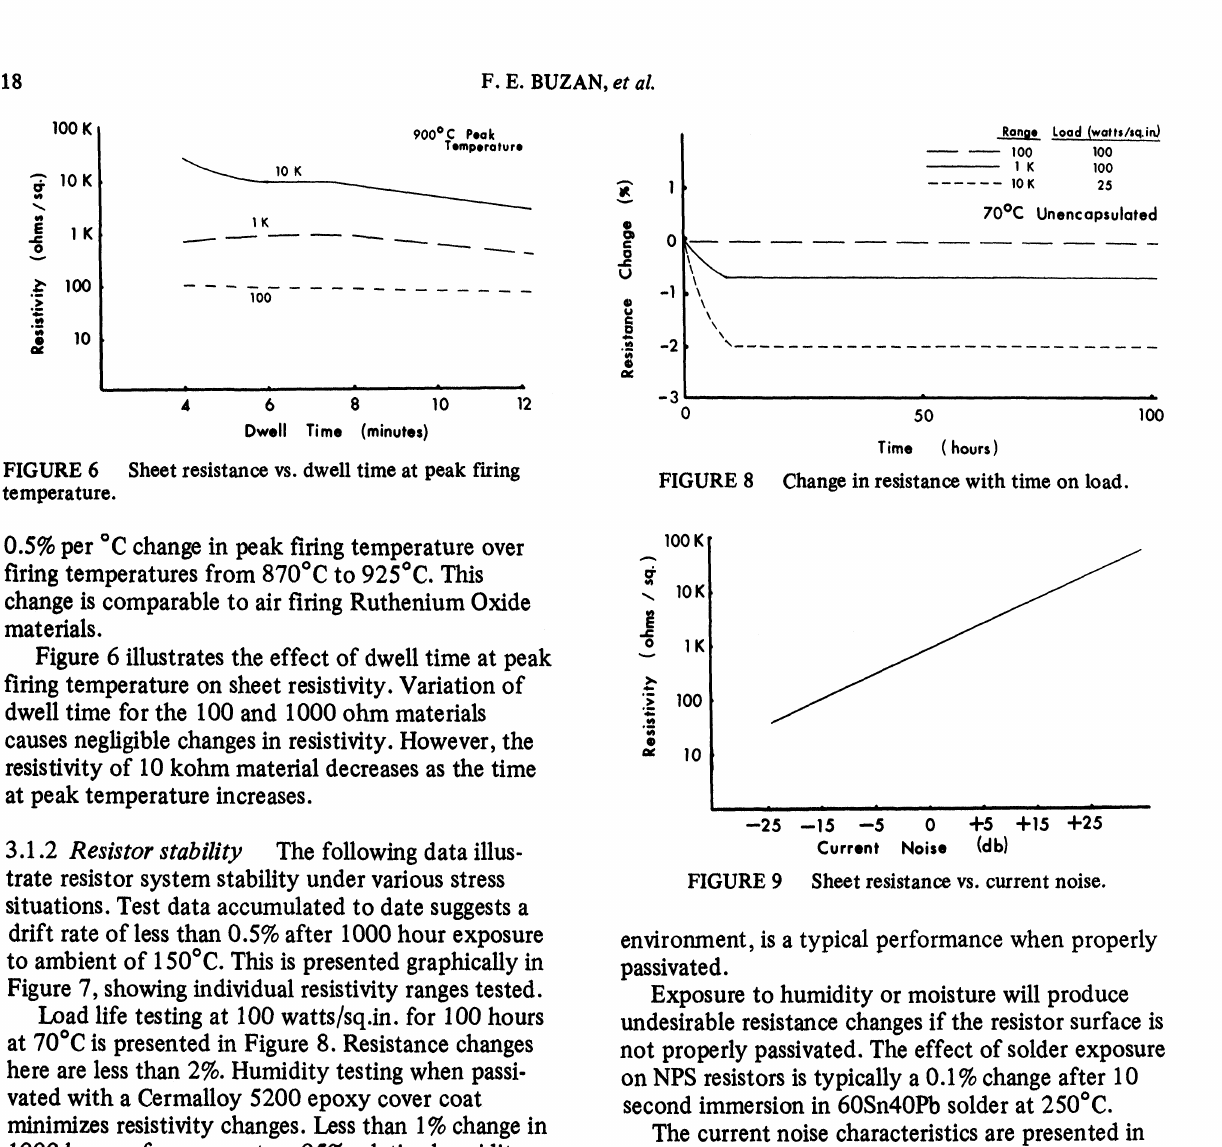
Sheet resistance vs. current noise. FIGURE